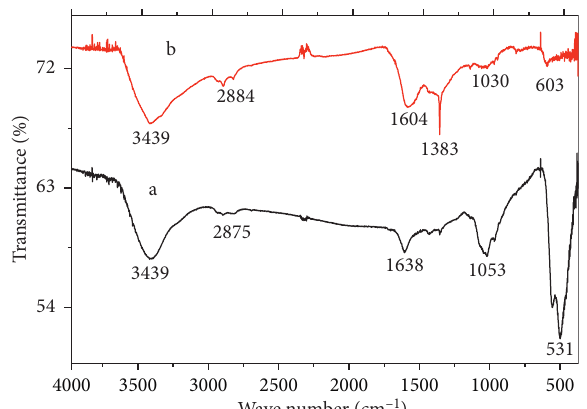
Figure 8: FTIR spectra of (a) calcinated and (b) as-synthesized CuO NPs synthesized from copper (II) nitrate trihydrate and leaf extract of Catha edulis in 1 :10 ratio (w/v).